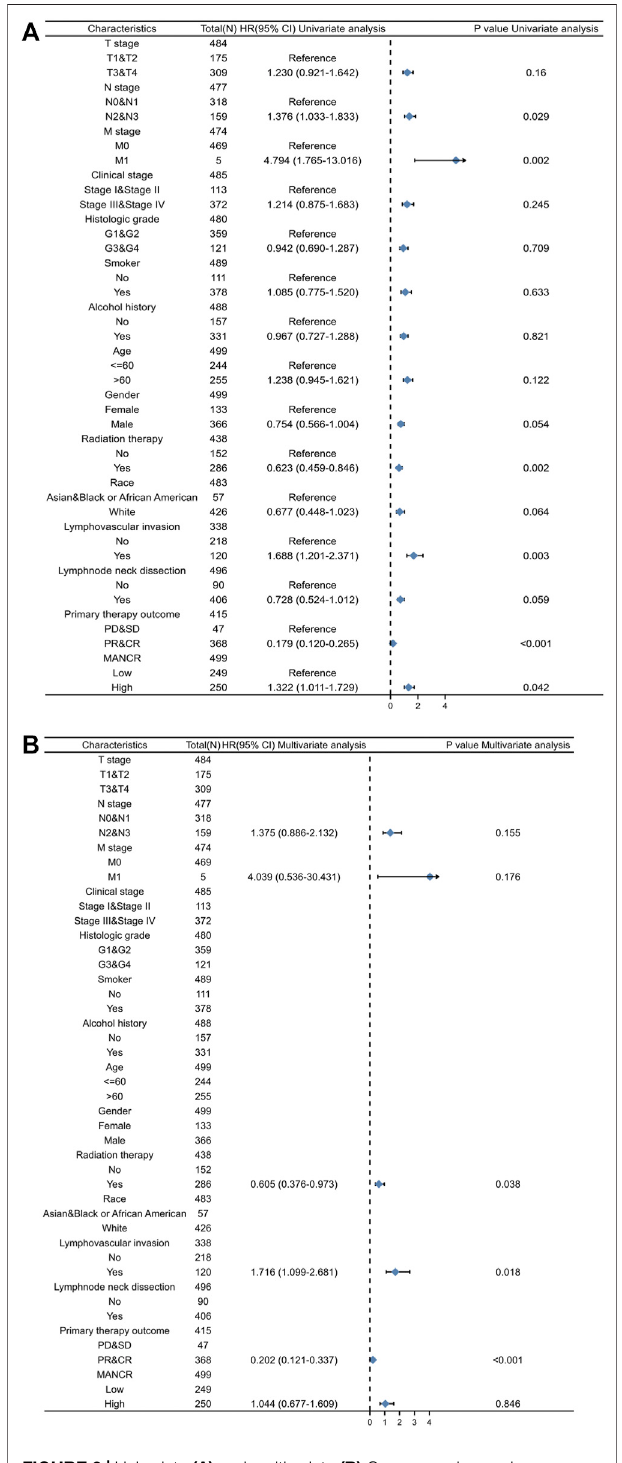
FIGURE 3 | Univariate (A) and multivariate (B) Cox regression analyses of clinicopathological parameters and overall survival ( p < 0.05 was regarded as signi fi